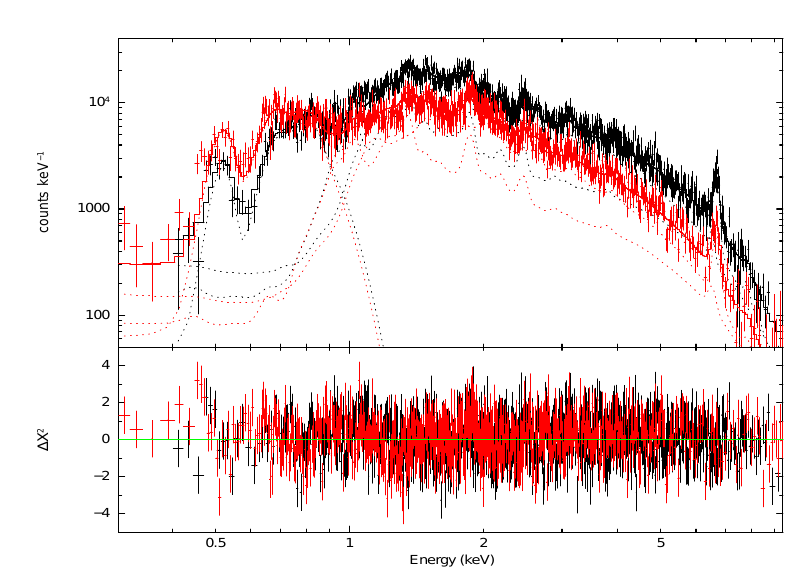
Fig. 1. The Suzaku X-ray spectra (black: XIS0+XIS3; red: XIS1) of V407 Cyg obtained on day 30, (cid:12)tted with a two component (one in collisional ionization equilibrium and the other not) plasma model plus a supersoft